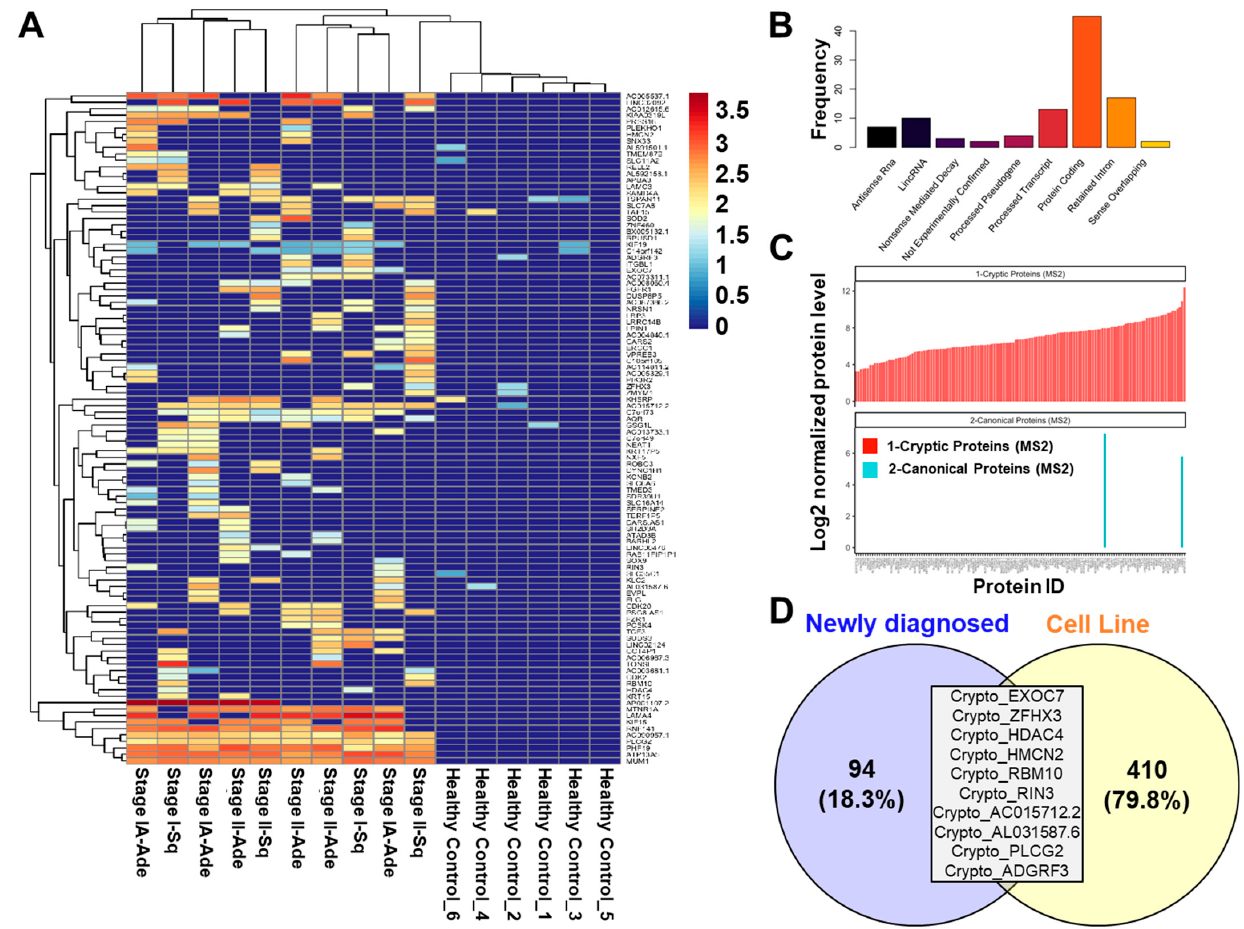
Figure 2. A unique Ig-bound cryptoprotein signature is detected in plasma from individuals newly diagnosed with NSCLC: ( A ) Heatmap depicting 104 Ig-bound cryptoproteins that are either uniquely identified or had a fold-change greater than 2 in cases compared to controls. Abbreviations: Sq, Squamous Cell Carcinoma; Adc, Adenocarcinoma. ( B ) Types of cryptoproteins that were elevated in the Ig-bound fraction of newly diagnosed lung cancer cases compared to controls. ( C ) Comparison of Ig-bound cryptoproteins and their canonical counterparts reveals near exclusivity of Ig reactivity against cryptoproteins. ( D ) Venn diagram illustrating overlap between cryptoproteins identified in lung adenocarcinoma cell lines with cryptoproteins that were elevated in the Ig-fraction of newly diagnosed lung cancer cases.